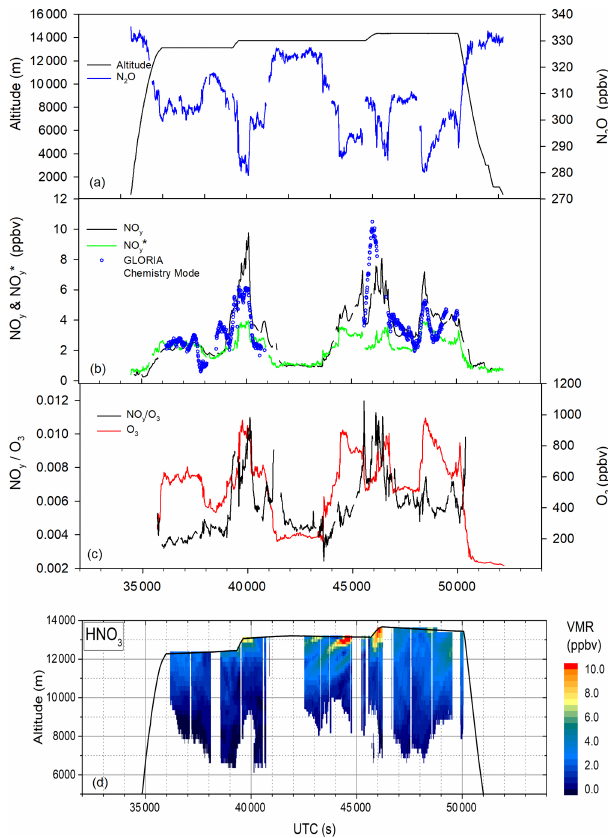
Figure 2. PGS flight 7 on 18 January 2016. (a) Altitude and N 2 O; (b) NO y (observed), NO ∗ y (calculated), and HNO 3 (GLORIA instru- ment); (c) NO y / O 3 ratio and O 3 ; and (d) HNO 3 observed with GLORIA.